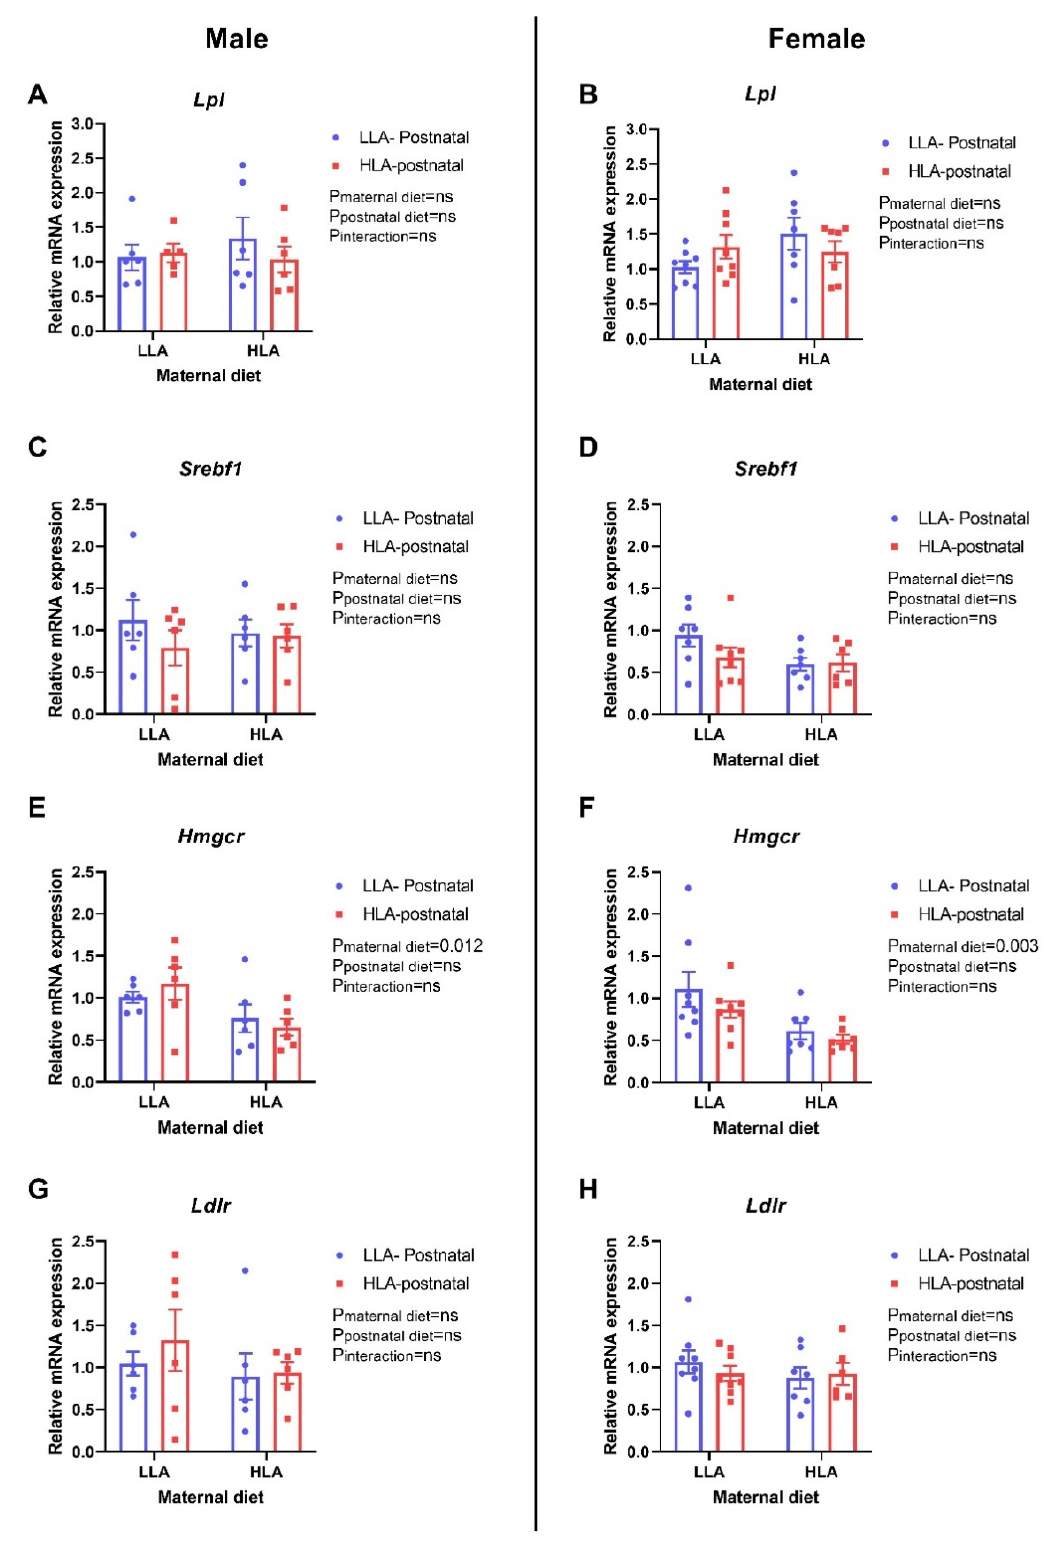
Figure 10. Effect of a maternal and postnatal diet high in linoleic acid on the expression of genes related to lipid metabolism in the liver of adult offspring. Data are presented as mean ± standard error of the mean (SEM). Two-way ANOVA was performed for statistical analysis with maternal diet and postnatal diet as two factors. n = 6–8. LLA: low linoleic acid; HLA: high linoleic acid; PN: postnatal. A : Lpl mRNA male; B : Lpl mRNA female; C : Srebf1 mRNA male; D : Srebf1 mRNA female; E : Hmgcr mRNA male; F : Hmgcr mRNA female; G : Ldlr mRNA male; H : Ldlr mRNA female.